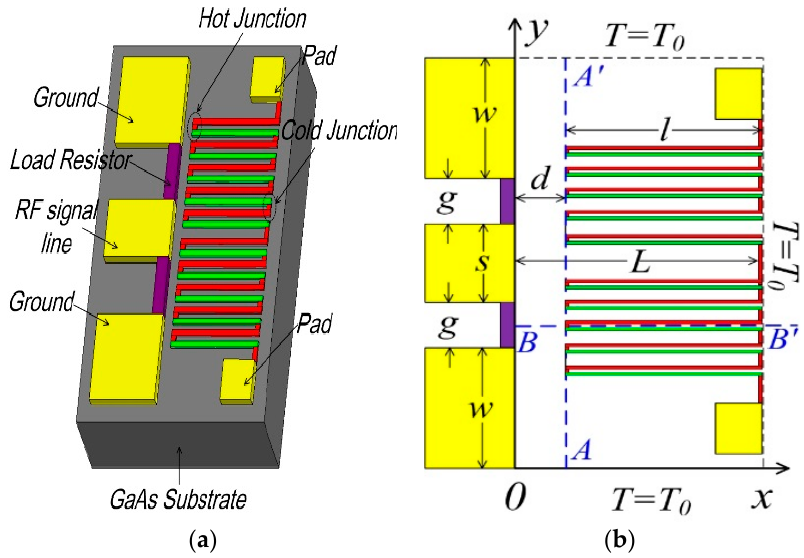
Figure 1. ( a ) Schematic overview and ( b ) dimension parameters of the thermoelectric microwave power sensor.